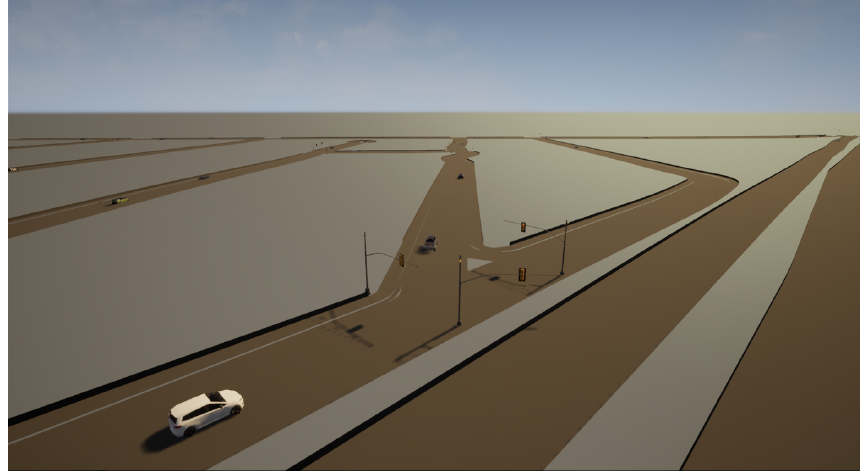
Figure 11. CARLA world generated from an OpenDrive file, with